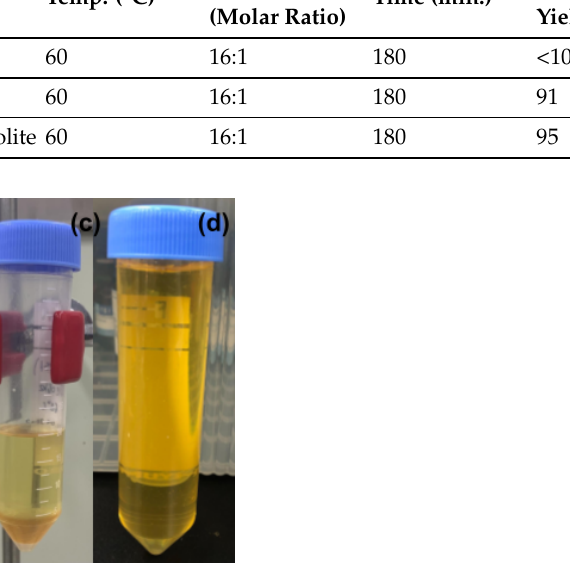
Figure 8. Phase-separated transesterification reaction mixture using catalysts: ( a ) zeolite, ( b ) NaOMe, ( c ) NaOMe/zeolite, ( d )